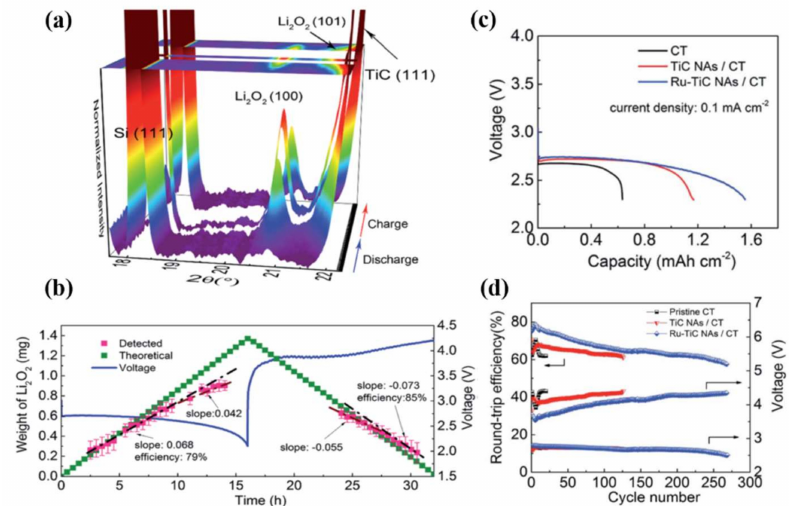
Figure 4. ( a ) Operando synchrotron radiation powder X-ray di ff raction (SP-PXRD) patterns for a Ru-TiC NAs / CT electrode at a wavelength of 0.994 A, recorded every 30 min during the first cycle